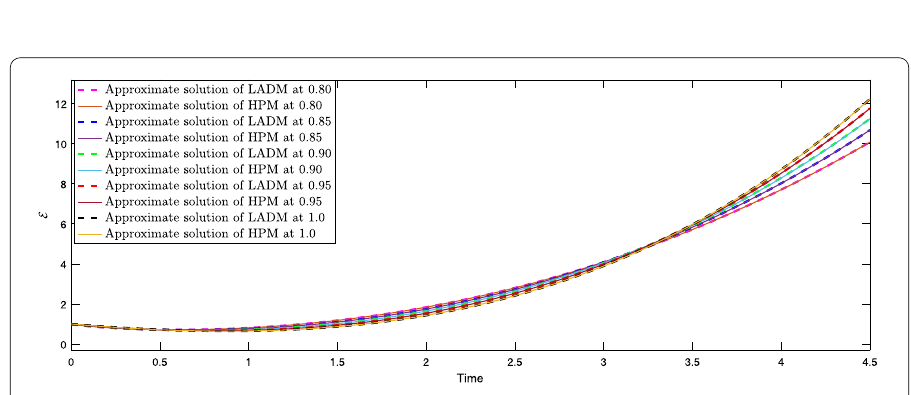
Figure 2 Comparison between the approximate solutions for E of model (3) for various fractional orders up to first three terms